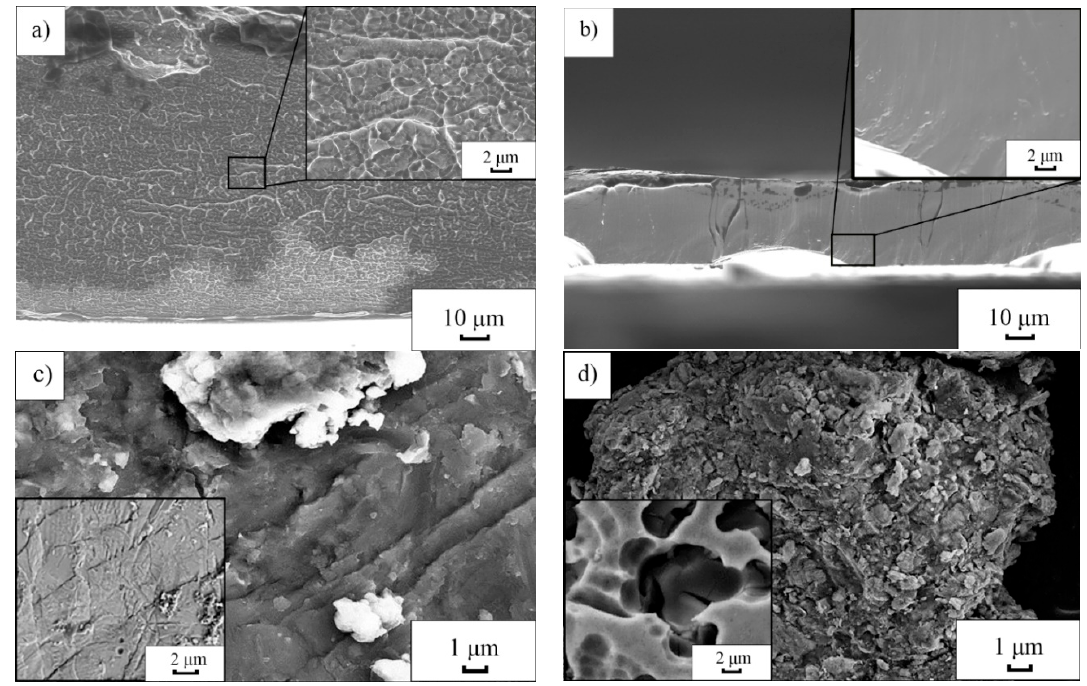
Figure 2. Micrographs of the fracture surface of as-spun Al 86 Ni 9 La 5 ribbons with different S c : ( a ) S c = 14.7 m/s; ( b ) S c = 36.6 m/s. SEM images of the Al 86 Ni 9 La 5 powders with different S c after 12 min cryomilling: ( c ) S c = 14.7 m/s; ( d ) S c = 36.6 m/s. The insets in ( c , d ) are the SEM images of the